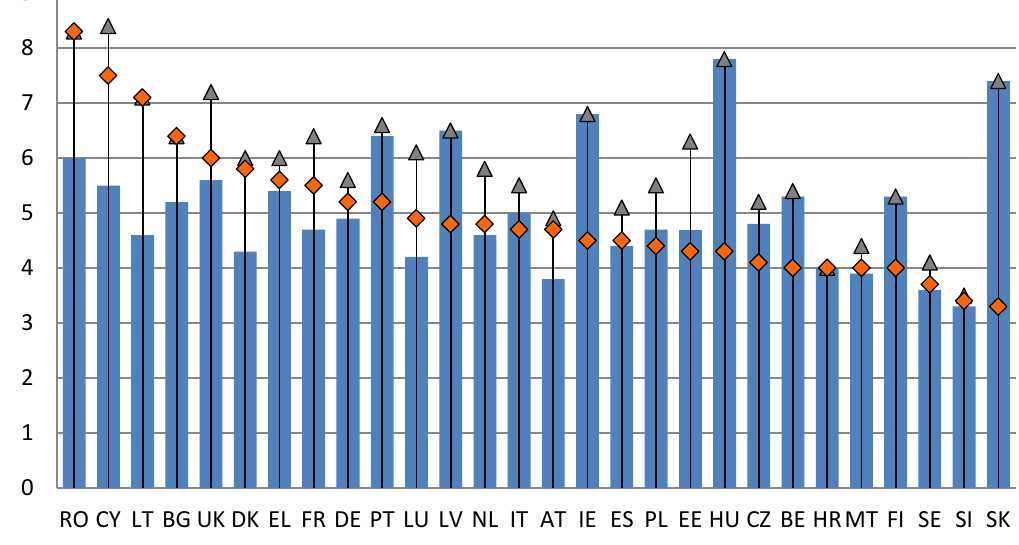
Figure 3. Income share by the hundredth percentile in the EU-28 countries (2006, 2015, and period peak) . Source: Own elaboration based on statistics from Eurostat. Notes: (i) Countries appear ranked according to the highest income share by the richest 1% in 2015. (ii) Croatia's data correspond to 2010 instead of 2006; Romania's data correspond to 2007 instead of